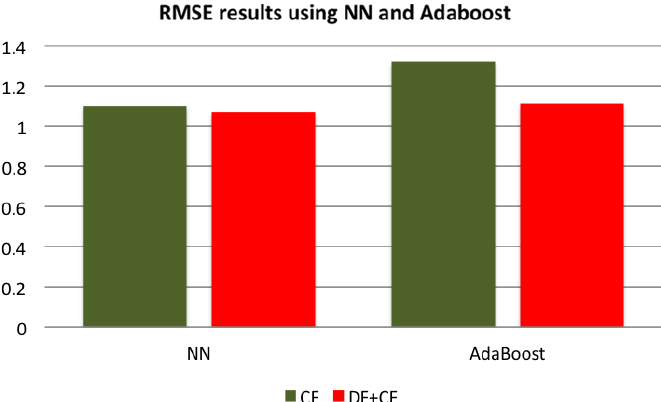
Fig. 7. RMSE results for the MovieLens dataset using NN and AdaBoost